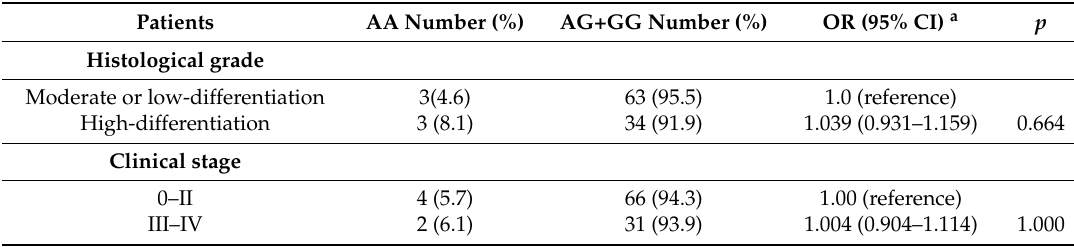
Table 4. The genotype frequencies in different histological grades and clinical stages of laryngeal cancer cases.